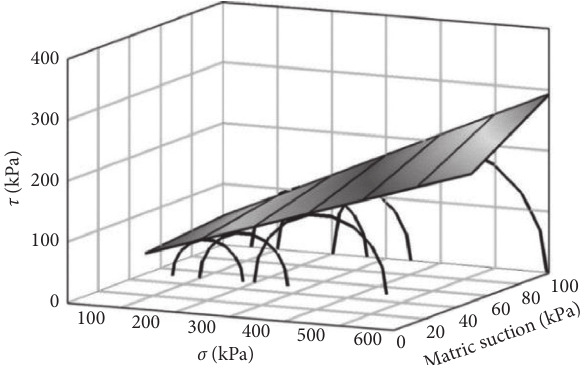
Figure 8: The Mohr circles of shear strength of unsaturated loess.